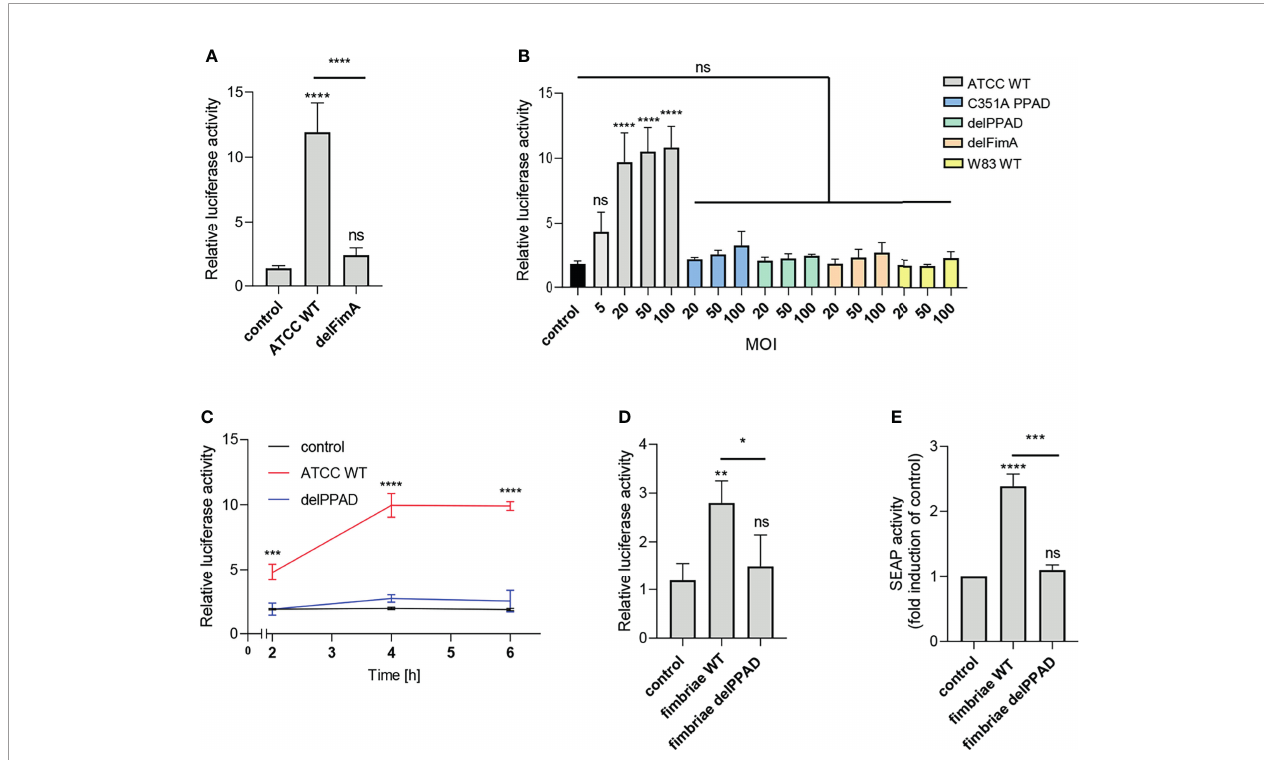
FIGURE 2 | Fimbriae puri fi ed from the wild-type ATCC 33277 strain activate the TLR2 receptor. U251 MG cells overexpressing TLR2 were: (A) infected for 4 h with WT ATCC 33277 and its isogenic major fi mbriae (delFimA) mutant strain (MOI=100), n=4-5 (B) infected for 4 h with various ATCC 33277-derived PPAD and FimA mutants as well as the WT W83 strain at different MOI (all strains MOI=20-100 with an additional MOI=5 for WT ATCC 33277), n=3 or (C) infected for 2, 4 or 6 h with WT ATCC 33277 or the PPAD mutant strains (MOI=100), n=3; and (D) treated for 4 h with puri fi ed fi mbriae (10 µg/ml) from WT ATCC 332771 (FimA WT) or the PPAD mutant (FimA delPPAD) strains; n=4. Results are presented as the mean ± SD ratio of Fire fl y luciferase activity to b -galactosidase activity and are normalized to cells stimulated/infected with the same factor and transfected with an empty vector. (E) HEK Blue cells overexpressing TLR2 were treated with puri fi ed fi mbriae (10 µg/ml) isolated from the WT ATCC 33277 strain (FimA WT) or the PPAD mutant (FimA delPPAD), n=3. Results are presented as the mean ± SD fold induction compared to control (unstimulated) cells. ****p < 0.0001; ***p < 0.001; **p < 0.01; *p < 0.05; ns, no statistical signi fi cance. 1-way ANOVA followed by Tukey ’ s multiple comparisons test. In (B) each condition was compared to control uninfected cells and in (C) comparisons were performed for each timepoint separately and signi fi cant differences compared to WT ATCC 33277 are depicted in the